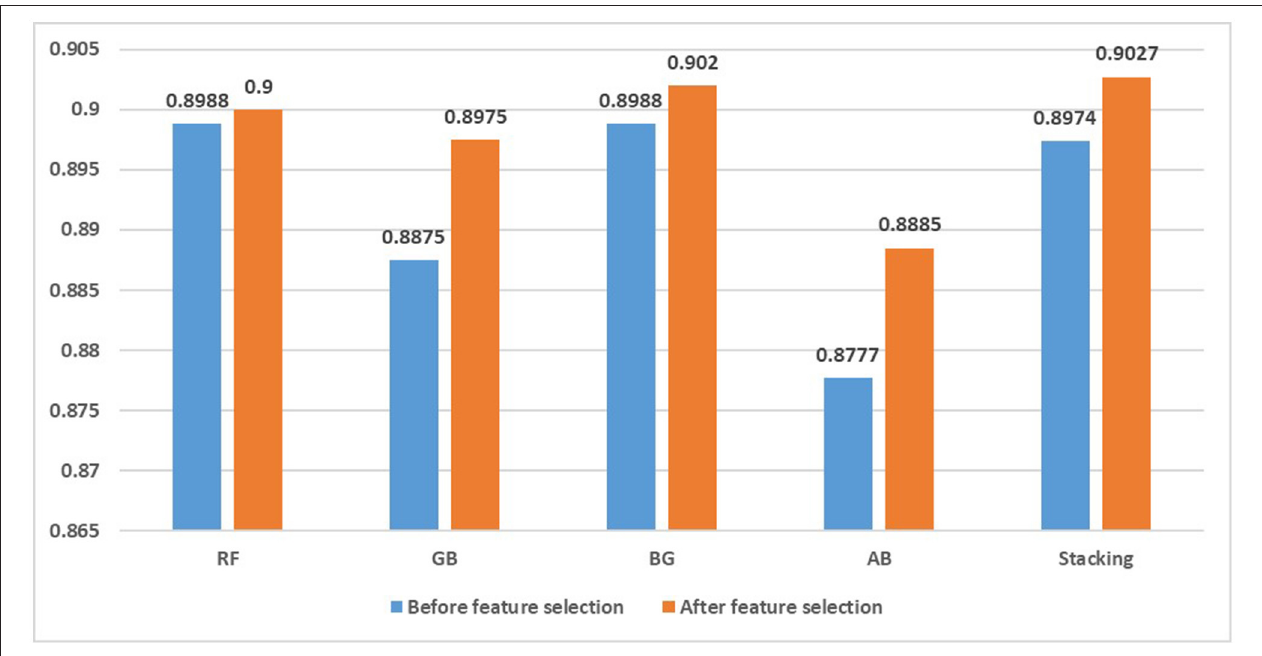
FIGURE 5 | Accuracy of integration method before and after feature